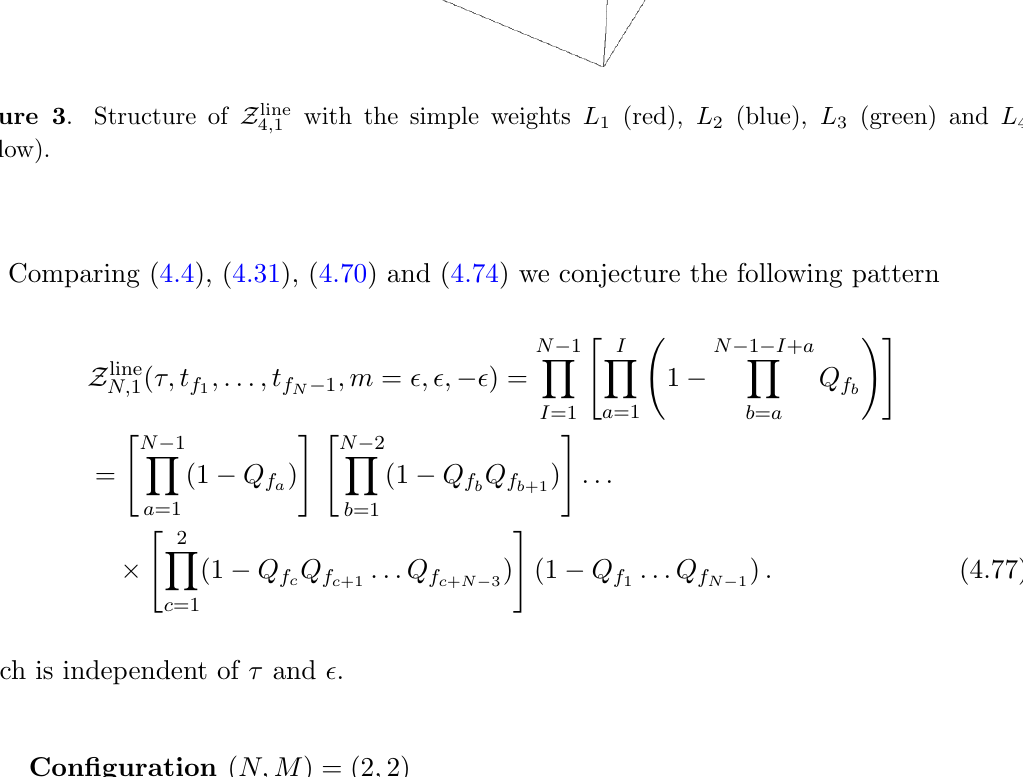
Figure 3 . Structure of Z line